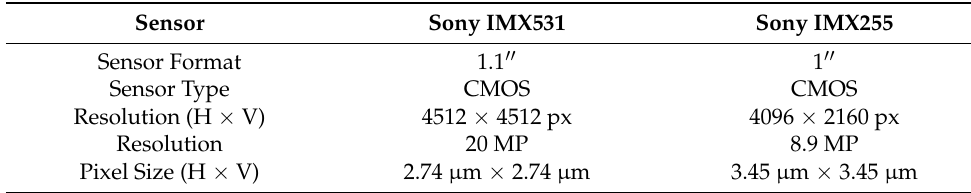
Table 2. Tested sensors.